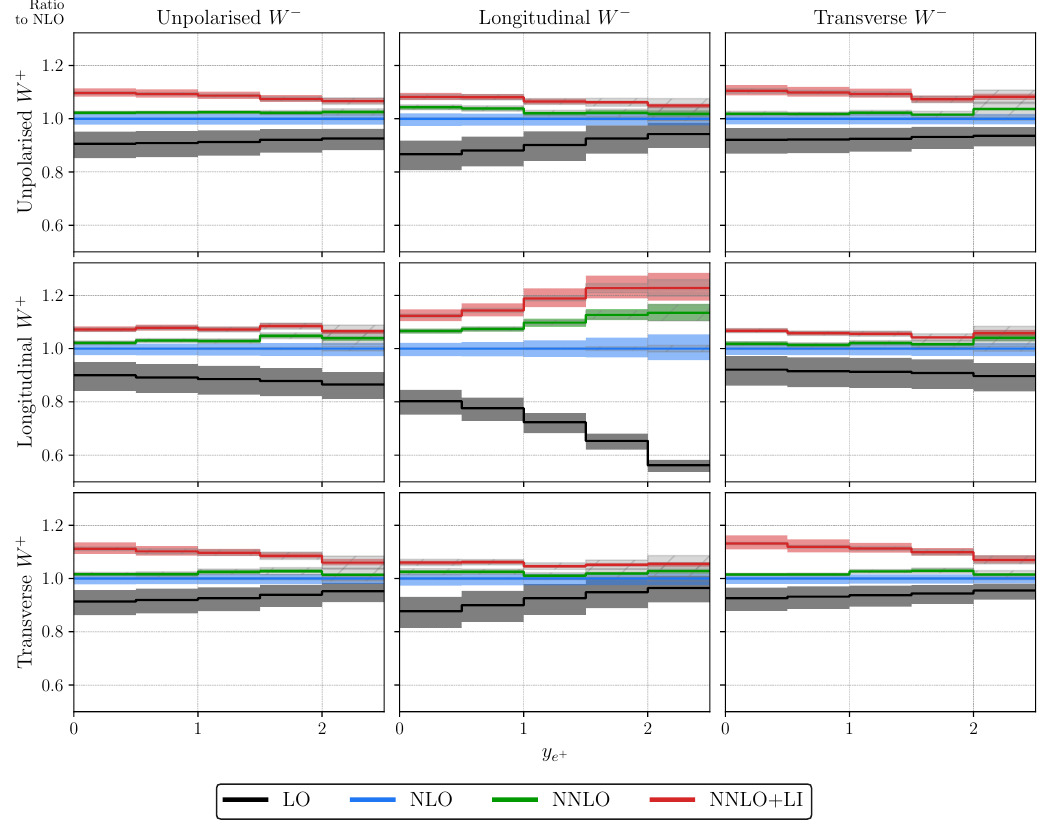
Figure 8 . Ratio to NLO of symmetrised e + rapidity distribution at various orders of perturbative QCD. Same plot structure as in figure